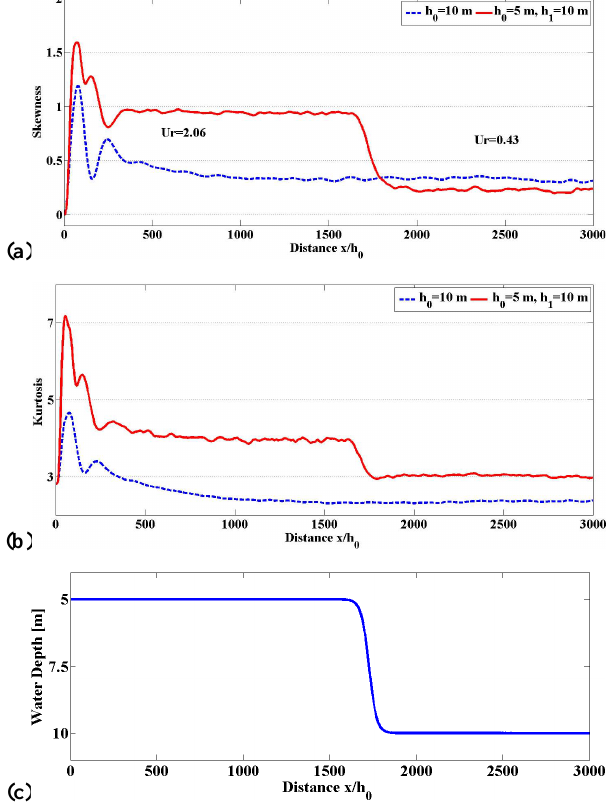
Figure 8. Variation of the skewness (a) and kurtosis (b) in the water of variable depth with initial Fig. 8. Variation of skewness (a) and kurtosis (b) in water value Ur = 2.06 (dashed line). The same variation in the water of constant depth h 0 = 5 m with of variable depth with initial value Ur =2.06 (solid line). The Ur = 0.43 (solid line). Variable depth profile with L = 30 h 0 (c). same variation in water of constant depth h 0 = 5m with Ur =0.43 (dashed line). Variable depth profile with L = 30 h 0 (c)